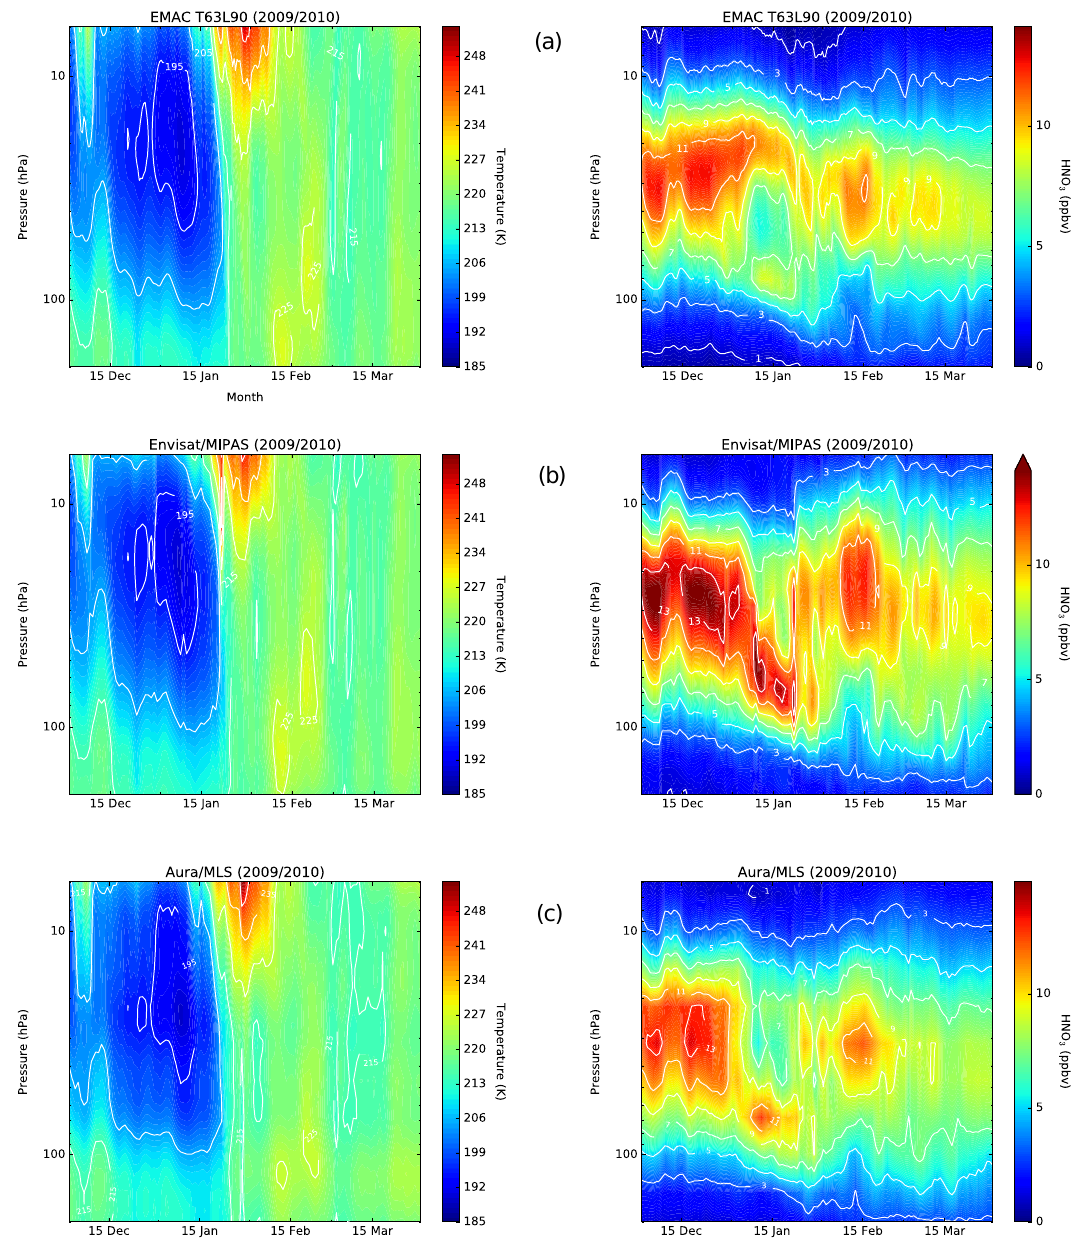
Figure 3. Temporal evolution of temperature and HNO 3 at northern high latitudes (70–90 ◦ N) as a function of pressure during the Arctic winter 2009/2010 (1 December 2009 to 31 March 2010). (a) EMAC, (b) Envisat/MIPAS, (c)